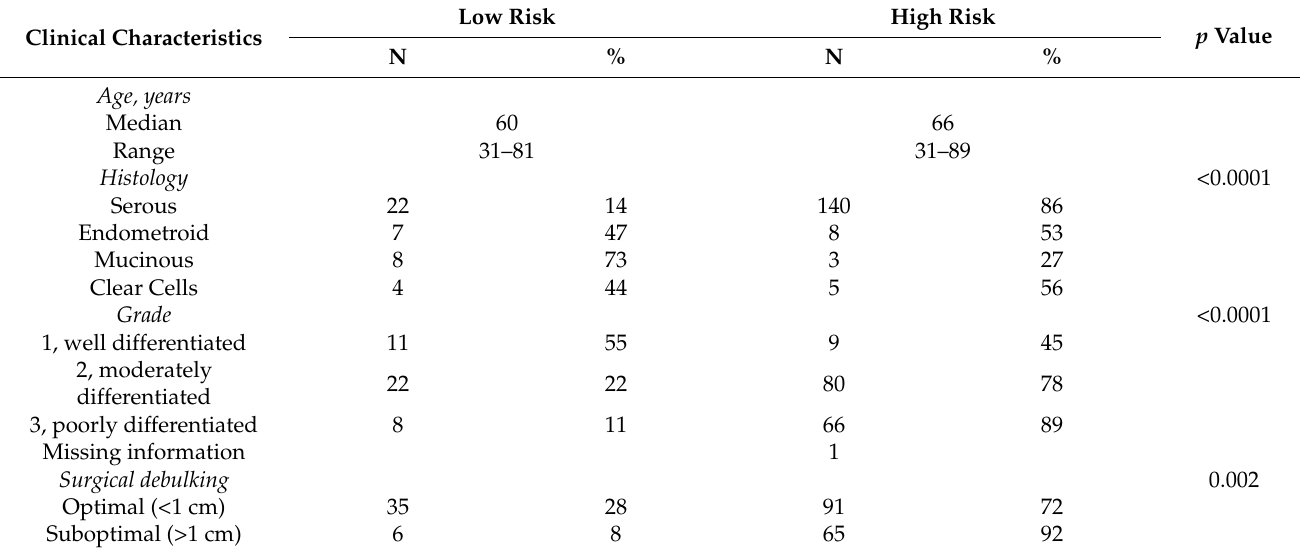
Table 1. Distribution of MiROvaR high- and low-risk patients from the Danish case material in relation to clinical and pathological variables. Clinical Characteristics